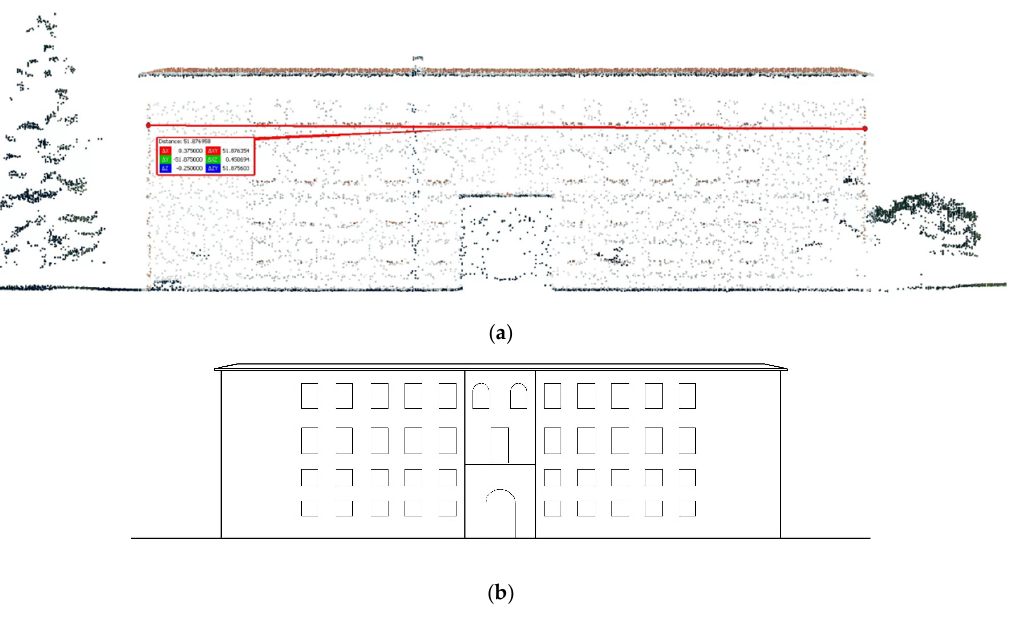
Figure 11. 2017 LiDAR cloud, density: 14 points/m 2 . UNAV campus: ( a ) measurements on the point cloud of the campus’s central building; ( b ) graphic survey of the same building façade.